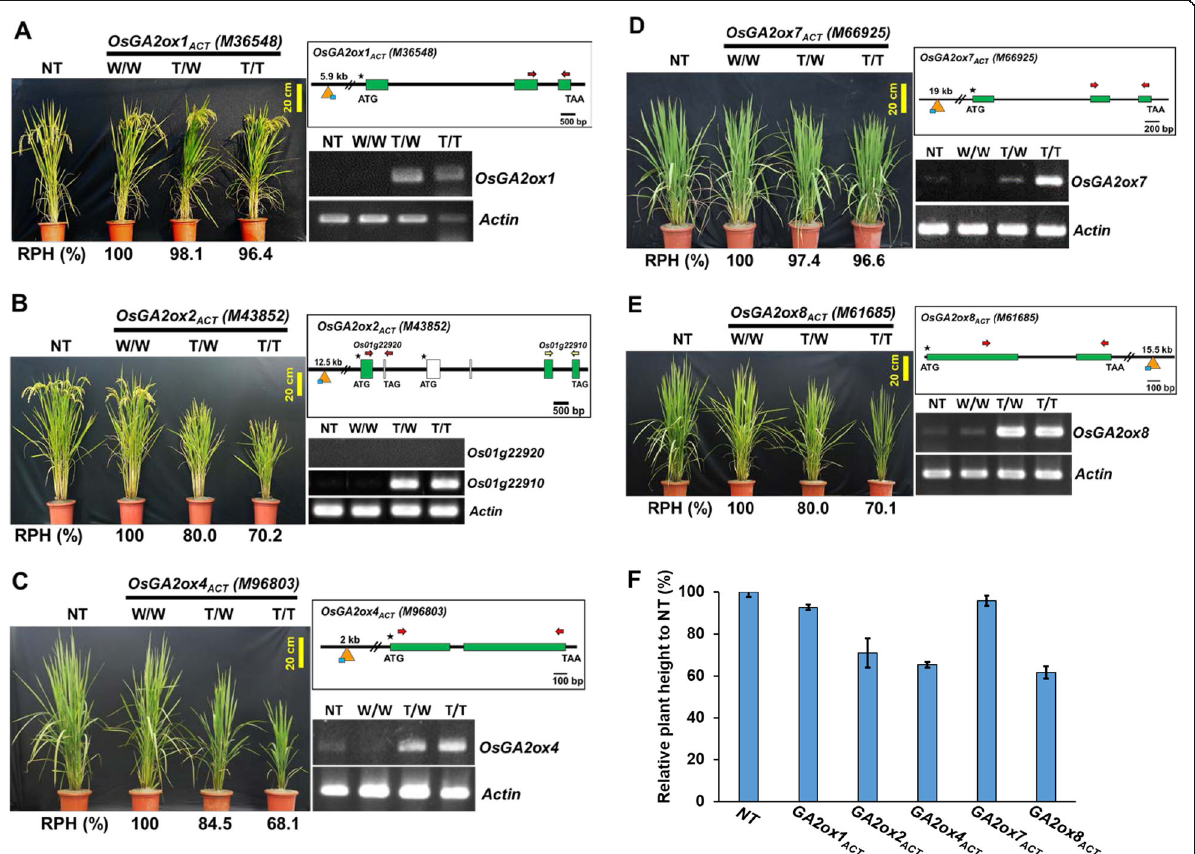
Fig. 1 Phenotypes and expression characterization of the T-DNA activation-tagged mutants for OsGA2ox1 , 2 , 4 , 7 , and 8. The phenotypes and relative plant height (RPH %) of T-DNA activation-tagged mutants (with various genotypes (W/W, segregated WT; T/W, heterozygous; T/T, homozygous)) compared with those of nontransgenic plants (NT) and the RT-PCR analysis results of target gene activation are shown. The Actin gene was used as a control. The T-DNA insertion sites (orange triangles) relative to the ATG start codon of their target genes are shown in the graphic adjacent to the images. a The T-DNA mutant M36548 (an OsGA2ox1 ACT mutant), with the T-DNA inserted 5.9 kb upstream from OsGA2ox1 , is shown. b The T-DNA mutant M43852 (an OsGA2ox2 ACT mutant), with the T-DNA inserted 12.5 kb upstream from OsGA2ox2 , is shown. c The T- DNA mutant M96803 (an OsGA2ox4 ACT mutant), with the T-DNA inserted 2 kb upstream from OsGA2ox4 , is shown. d The T-DNA mutant M66925 (an OsGA2ox7 ACT mutant), with the T-DNA inserted 19 kb upstream from OsGA2ox7 , is shown. e The T-DNA mutant M61685 (an OsGA2ox8 ACT mutant), with the T-DNA inserted 15.5 kb downstream from OsGA2ox8 , is shown. f RPH comparison of the homozygous plants of the above T- DNA activation-tagged mutants. Values are means ± SE ( n =